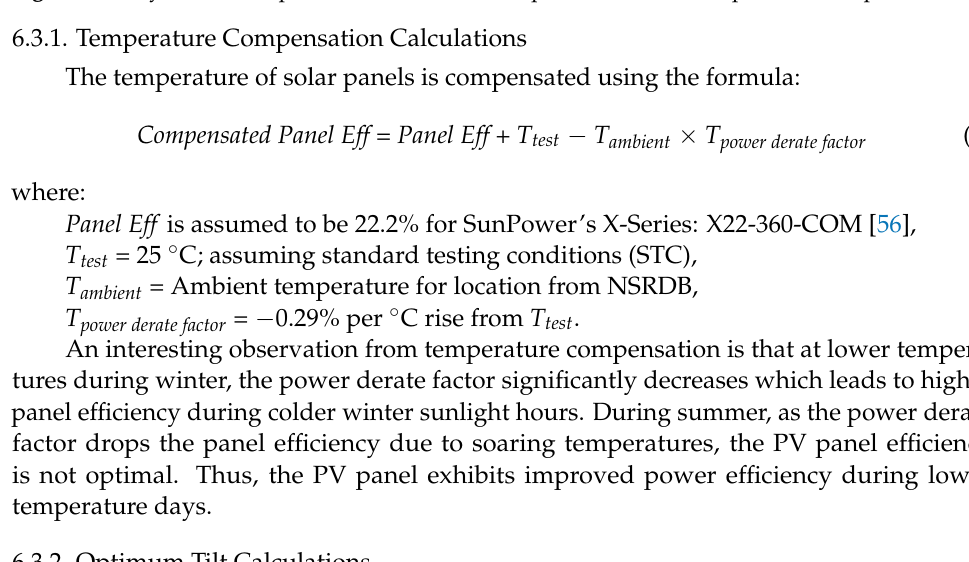
Figure 9. Daily irradiation profile of PV Farm with optimum tilt and temperature compensation.